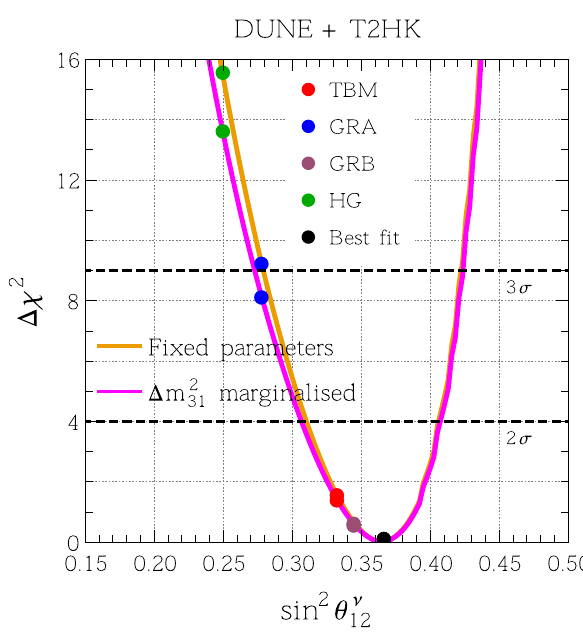
Fig. 5 Compatibility between various symmetry forms and present best fit values of neutrino oscillation parameters in light of the prospec- tive data from the combined DUNE + T2HK set-up. The black dot cor- = 0 . 364 obtained from Eq. (1.1) using the present responds to sin 2 θ ν 12 best fit values of θ 12 , θ 13 , θ 23 , and δ CP . The coloured dots correspond to the values of sin 2 θ ν for the TBM, GRA, GRB, and HG symmetry 12 forms. We show the results for the two different cases: (i) fixed param- eter scenario where all the oscillation parameters are kept fixed in the fit, and (ii) we only marginalise over (cid:6) m 2 in the fit in its present 3 σ 31 allowed